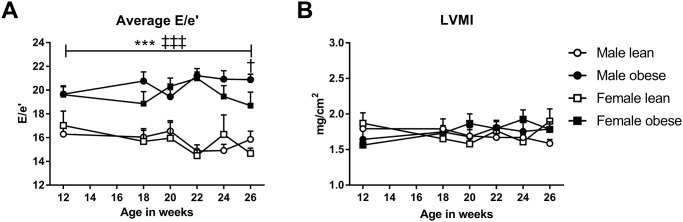
Obese ZSF1 rats show indication of diastolic dysfunction.A) Tissue Doppler Imaging showed that, already at an early age, the E/e’ ratio was markedly increased in both male and female obese ZSF1 rats compared to lean rats. B) Left ventricular mass index (LVMI) was similar between the four groups. Means ± SEM. Symbols as in Fig 1.